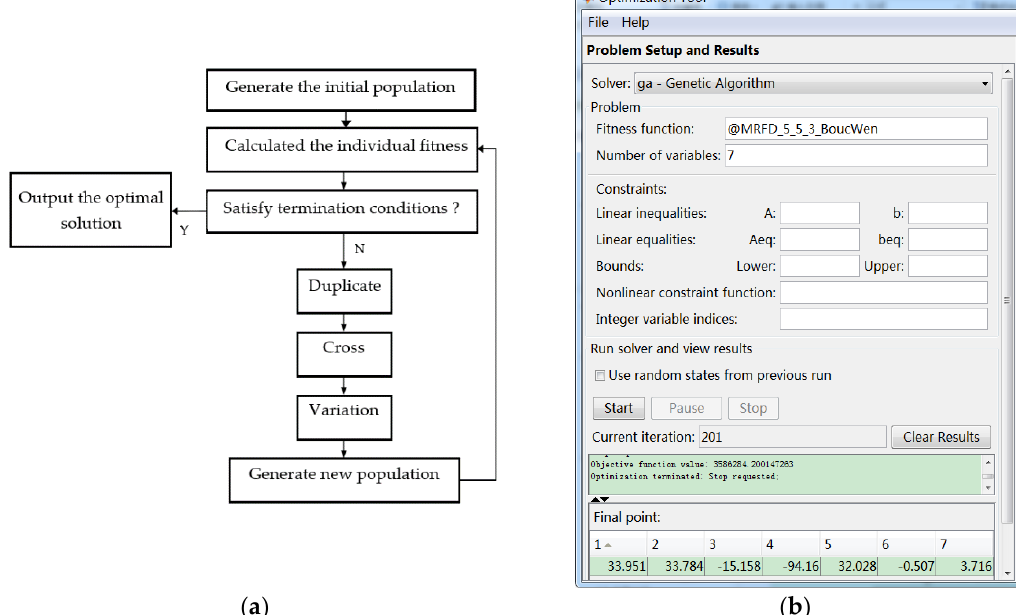
Figure 4. Genetic algorithm of parameter identification for the double-sigmoid model: ( a ) Flow chart of genetic algorithm; ( b ) Genetic algorithm toolbox.